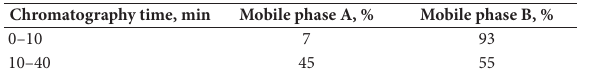
Table 1. Gradient